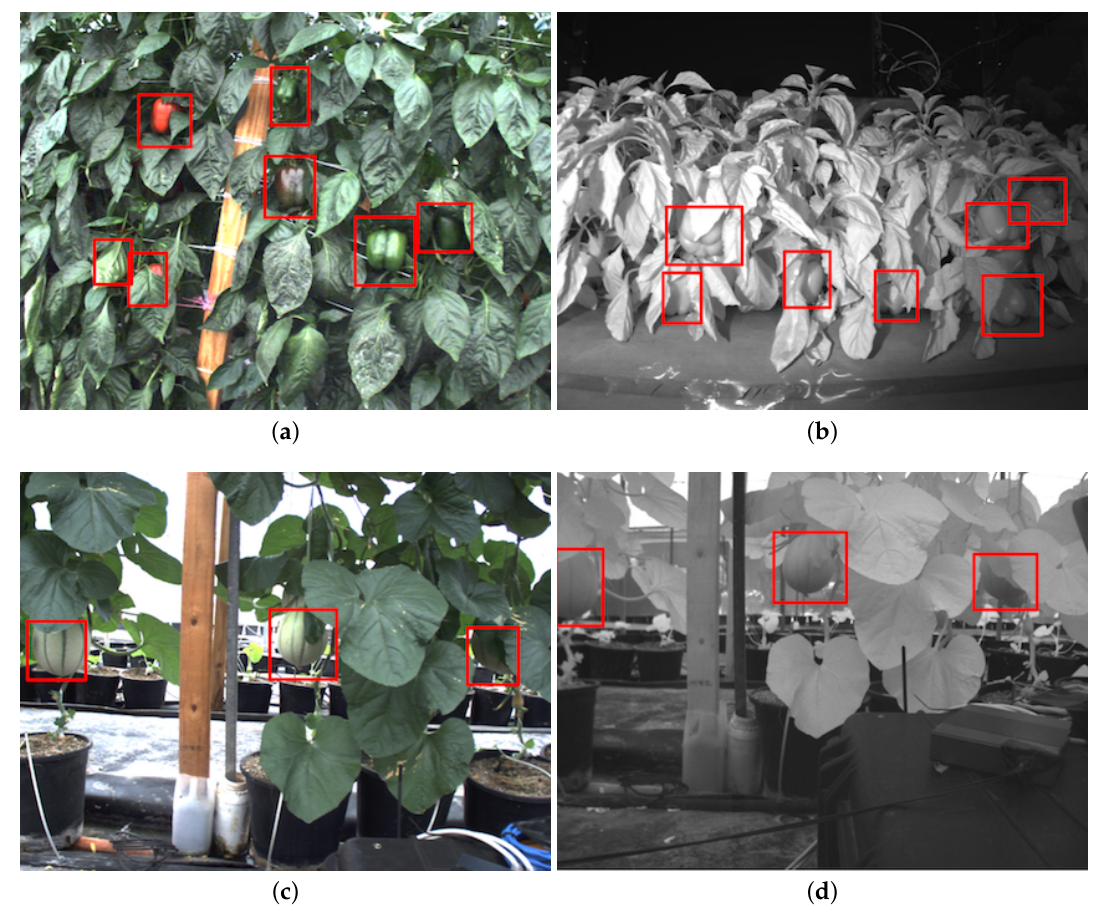
Figure 1. Example images of the detection for two fruits. ( a ) and ( b ) show a colour (RGB) and a Near-Infrared (NIR) image of sweet pepper detection denoted as red bounding boxes respectively. ( c ) and ( d ) are the detection of rock